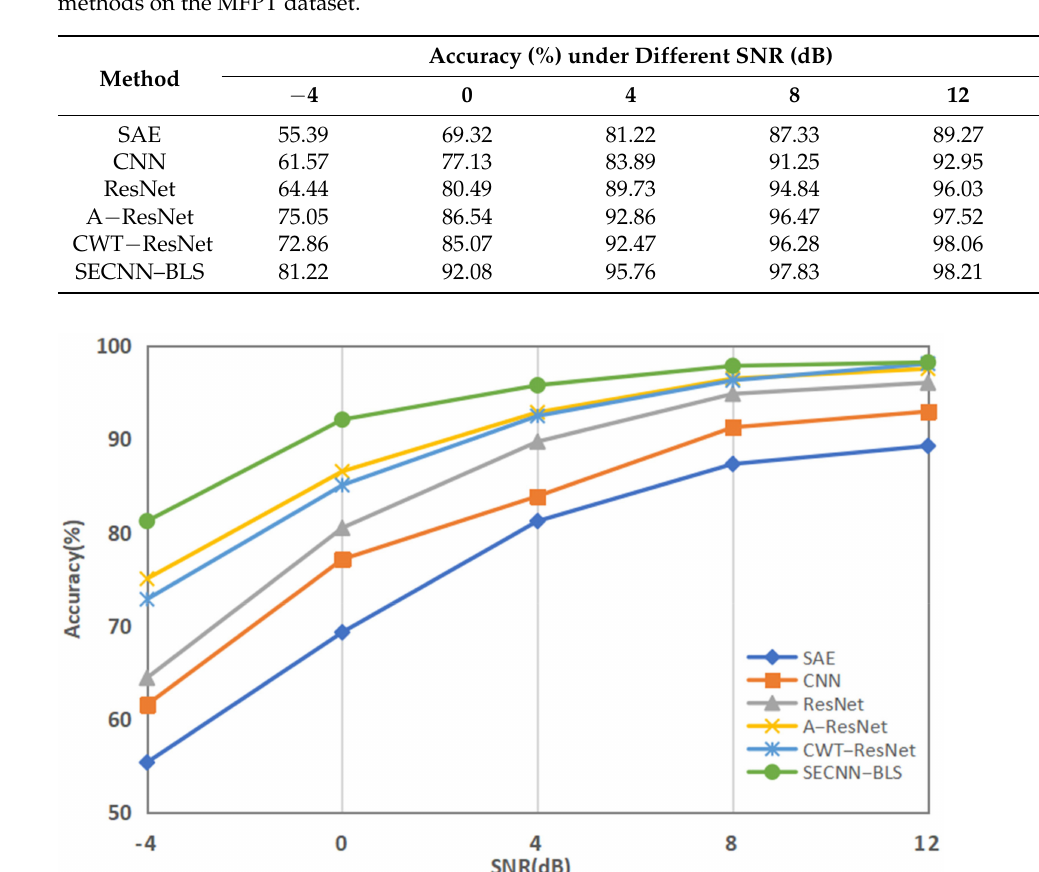
Figure 8. Comparison results of different methods in different noise